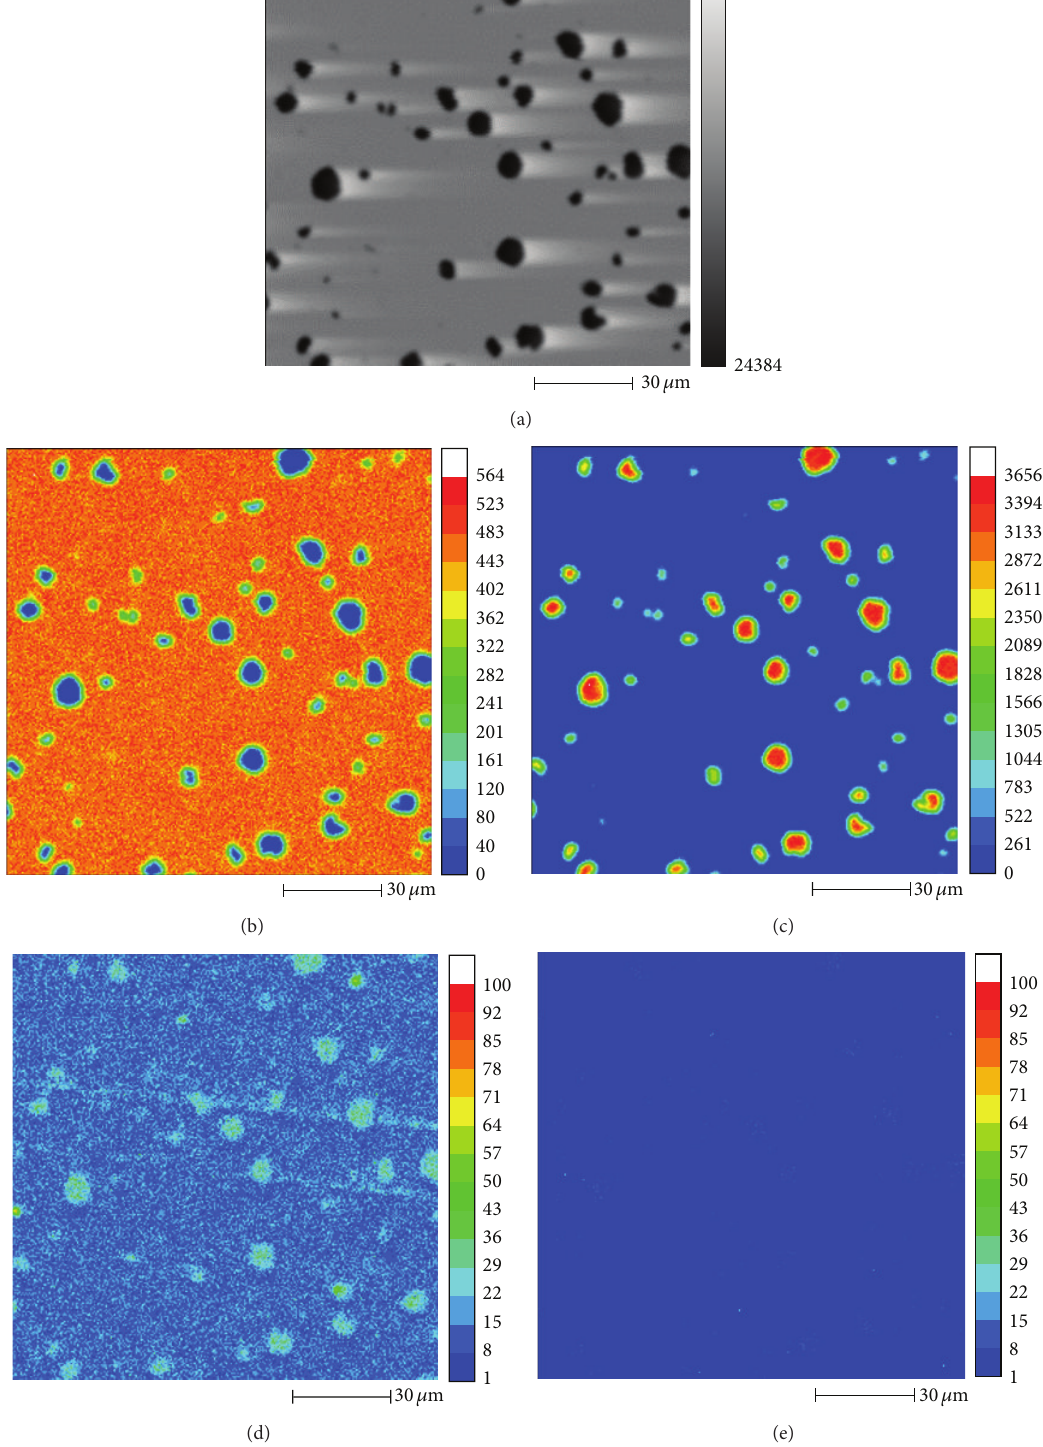
Figure 6: Elemental distribution analyzed by EPMA on the surface of DCI, which was passivated for 72 hours in tap water with 100k ppm NO 2− addition at 25 ∘ C. (a) SEM image, (b) Fe, (c) C, (d) O, and (e) N